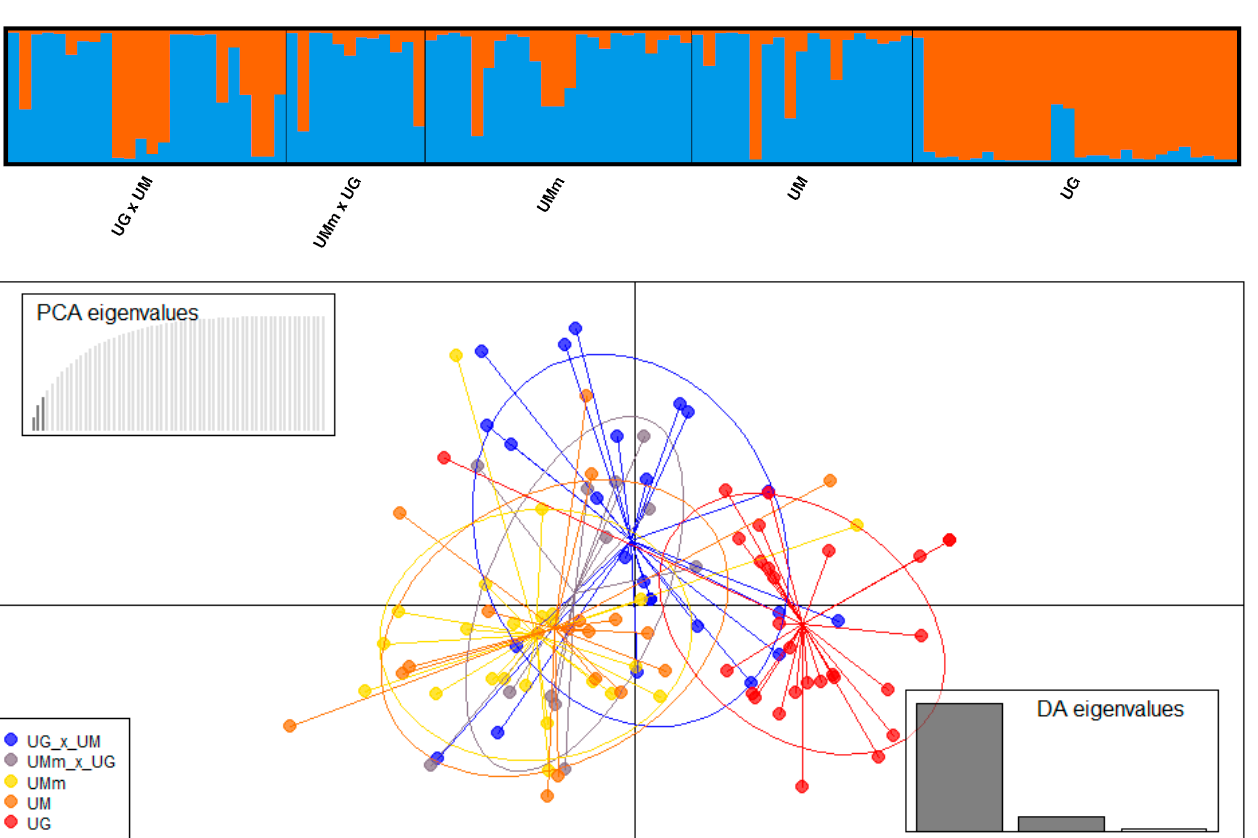
Figure 5. The upper plot shows the inferred structure clusters (K = 2) (soft. STRUCTURE2.3.4) [67]. In the CLUMPAK plot, everything is represented by a thin vertical line divided into K = 2 colored segments that represent the individual’s estimated membership fractions in these two clusters. Black lines separate individuals from different species groups. The first cluster (orange) displays the clear separation of the U. glabra (UG) group, and the second cluster (blue) indicates groups of U. minor (UM) and U. minor subsp. minor (UMm). The lower plot illustrates the genetic structure of five Ulmus species groups based on two major principal components from the DAPC analysis (R package adegent 2.0.0) [64,65].